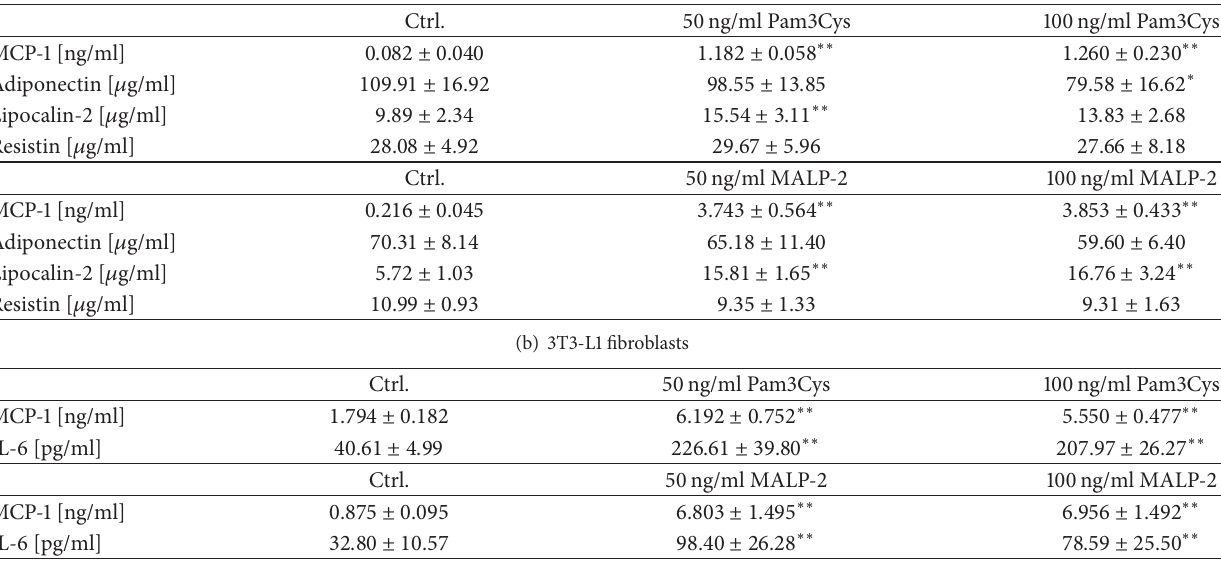
Table 3: Effect of lipopeptide stimulation on the secretion of adipokines, chemokines, and cytokines into the supernatant of mature 3T3-L1 adipocytes and of undifferentiated